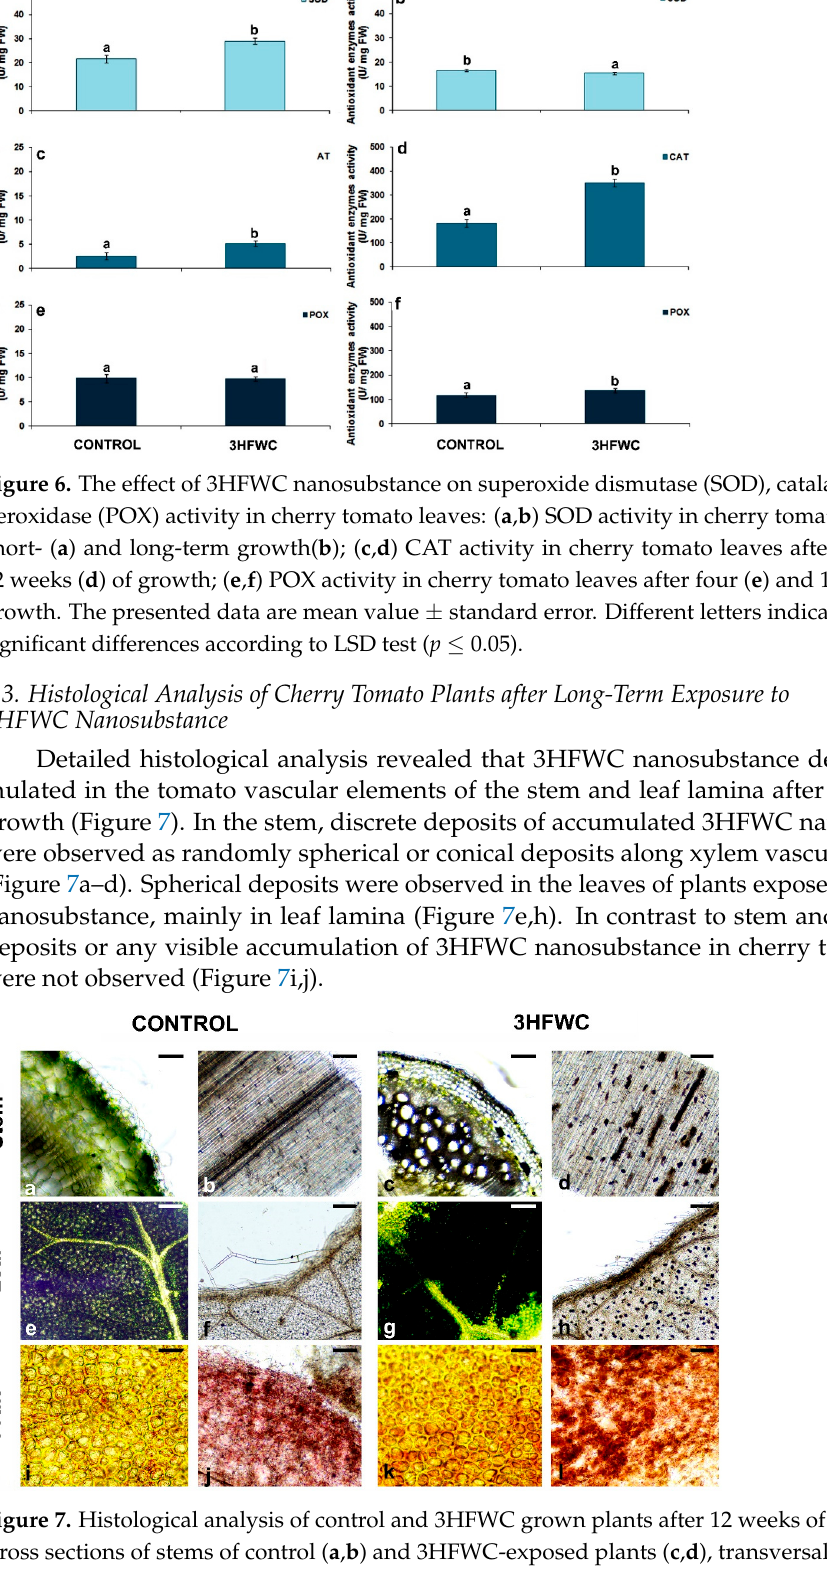
Table 3. The effect of 3HFWC nanosubstance on the morphological characteristics of tomato fruits. Plants